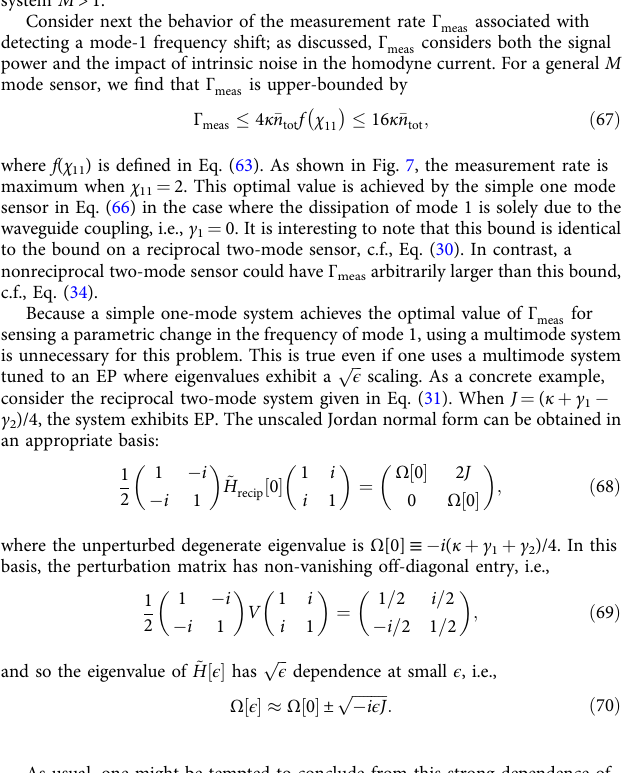
Fig. 7 Allowable values of function f ( χ 11 ). The shaded blue region indicates the allowable values of f ( χ 11 ) (c.f., Eq. (63)) as a function χ maximum possible measurement rate both for sensing a parametric change in mode coupling (c.f., Eq. (62)) and for sensing a parametric change in the resonance frequency of mode 1 (c.f., Eq. (67)). The dashed horizonal line shows the maximum possible value of f ( χ 11 ), which is achieved only when χ = 2. Note that for larger χ 11